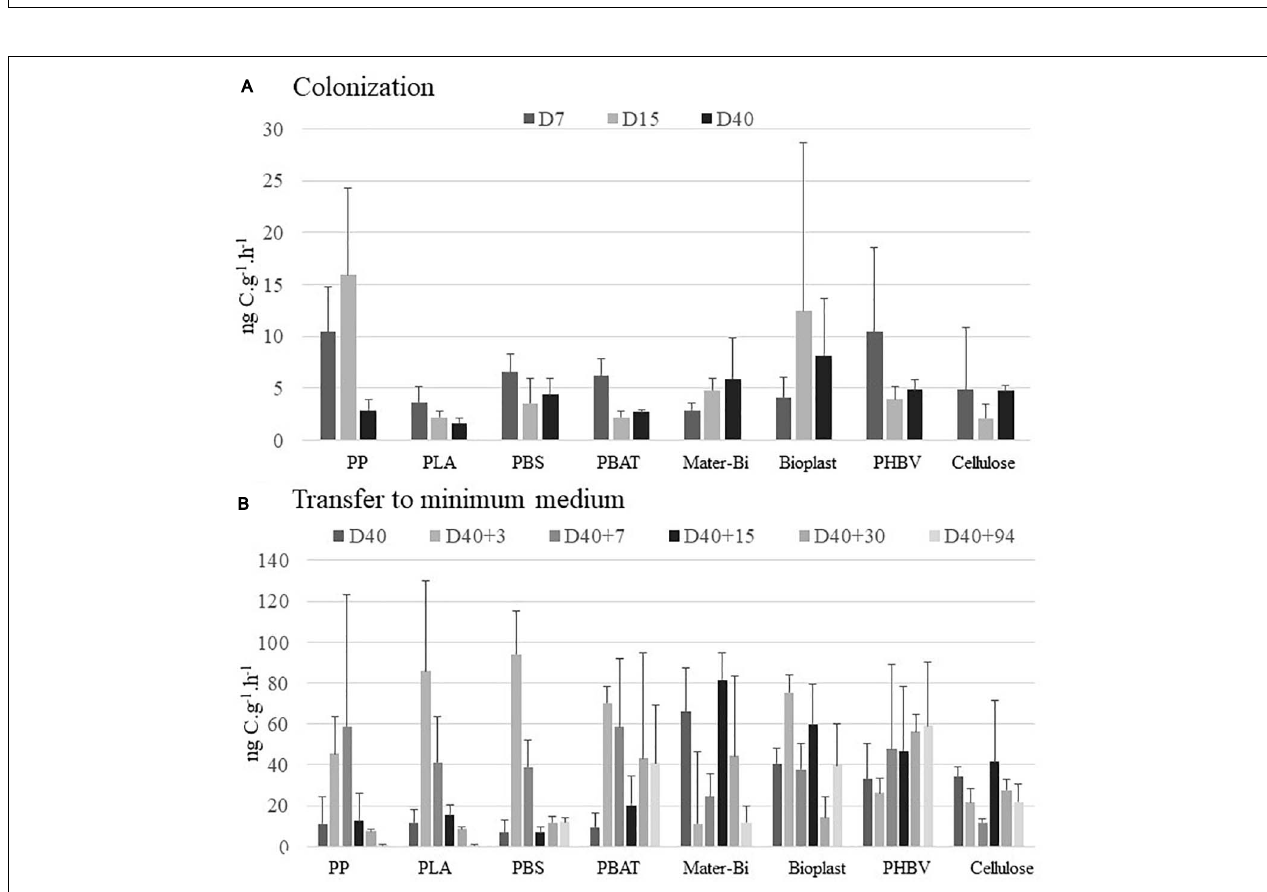
FIGURE 2 | Bacterial production (in ng C · g − 1 · h − 1 ) (A) during the colonization phase in natural seawater at days 7 (D7), 15 (D15), and 40 (D40) and (B) after the transfer to minimum medium during 3 (D40 + 3), 7 (D40 + 7), 15 (D40 + 15), 30 (D40 + 30), and 94 days (D40 + 94). The vertical bars represent the average of the bacterial production for each material ( n = 3) ± standard deviation. Changes in BP values at D40 between panels (A,B) correspond to changes on dilution factor of the 3 H-leucine added (see section “Materials and Methods”). BP, bacterial production.